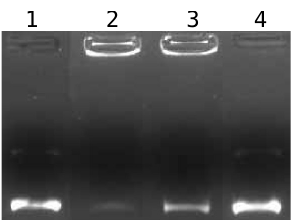
Figure 2. Effect of different concentration of ligands 6a on the interaction with pUC19 DNA (7 m g/ml) in a Tris-HCl buffer (100 mM, pH 7.4) at 37 ºC for 0.5 h. Agarose gel electrophoresis diagram: lane 1, DNA control ; lanes 2-4, ligand: [ 6a ] = 5.6, 4.2, 2.8 mM.